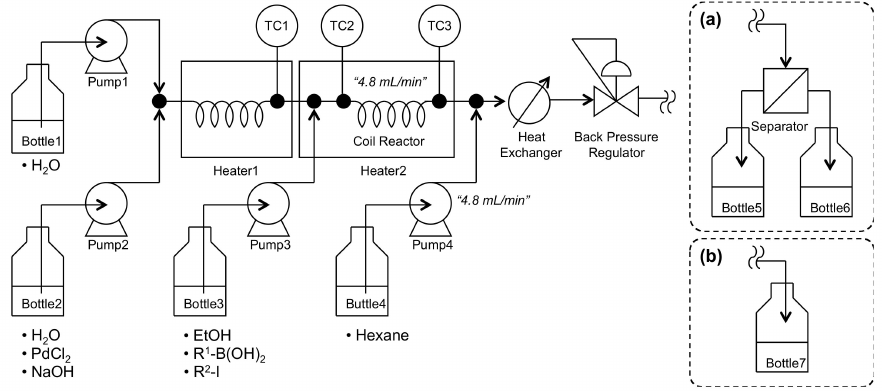
Figure 1. Schematic process configurations of sequential flow reaction for Suzuki-Miyaura Couplings (SMCs). ( a ) Separation by membrane separator into h-hexane phase and aqueous phase, ( b ) without separation.